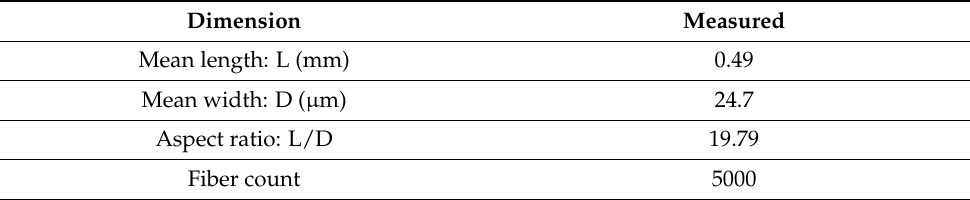
Table 1. Birch fiber characterization properties. Dimension